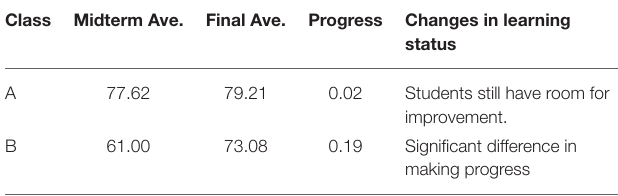
TABLE 7 | Student self-grow